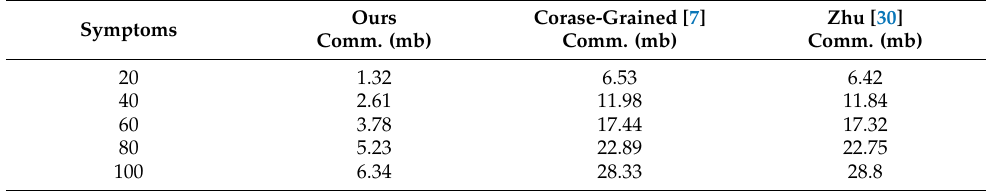
Table 4. Communication overhead for different schemes with different numbers of